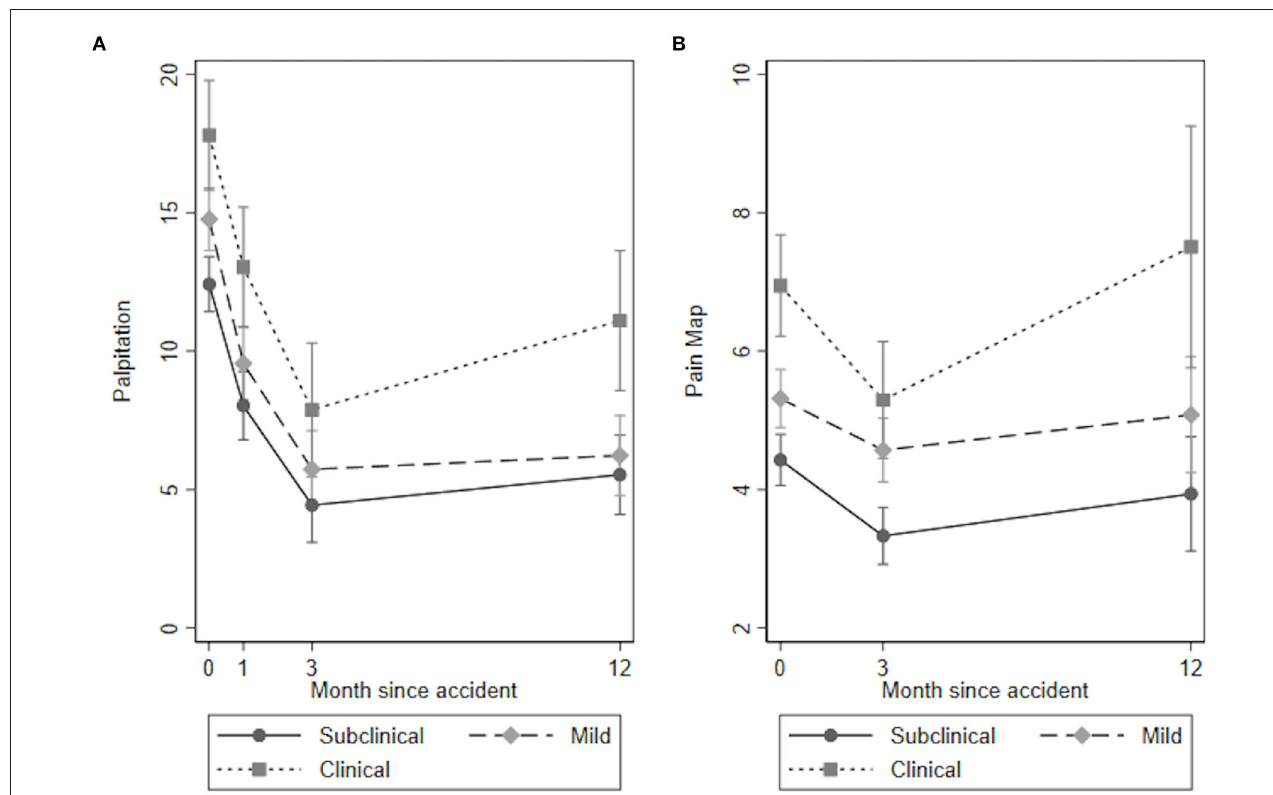
FIGURE 3 | Pain Distribution: (A) Palpation and (B) Pain Map.